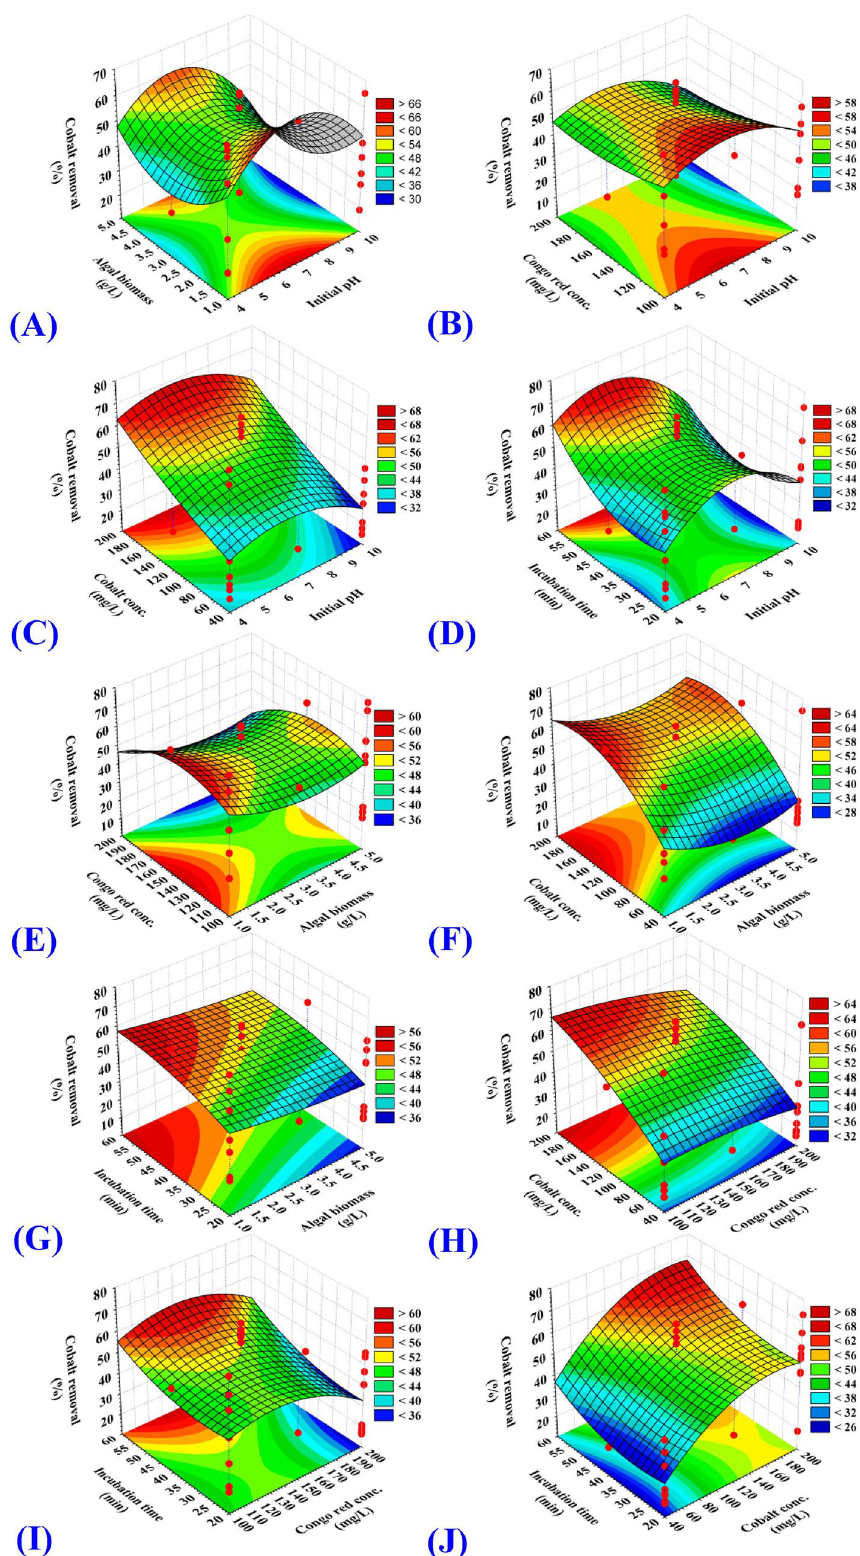
Figure 2. Three-dimensional surface plot for biosorption of cobalt by E.intestinalis biomass, showing the interactive effects of two variables at a time of the five tested variables. ( A ) initial pH level and algal biomass concentration, ( B ) initial pH level and Congo red concentration, ( C ) initial pH level and cobalt concentration, ( D ) initial pH level and incubation time, ( E ) algal biomass conc. and Congo red concentrations, ( F ) algal biomass and cobalt concentrations, ( G ) algal biomass concentration and incubation time, ( H ) Congo red and cobalt concentrations, ( I ) Congo red concentration and incubation time and ( J ) cobalt concentration and incubation